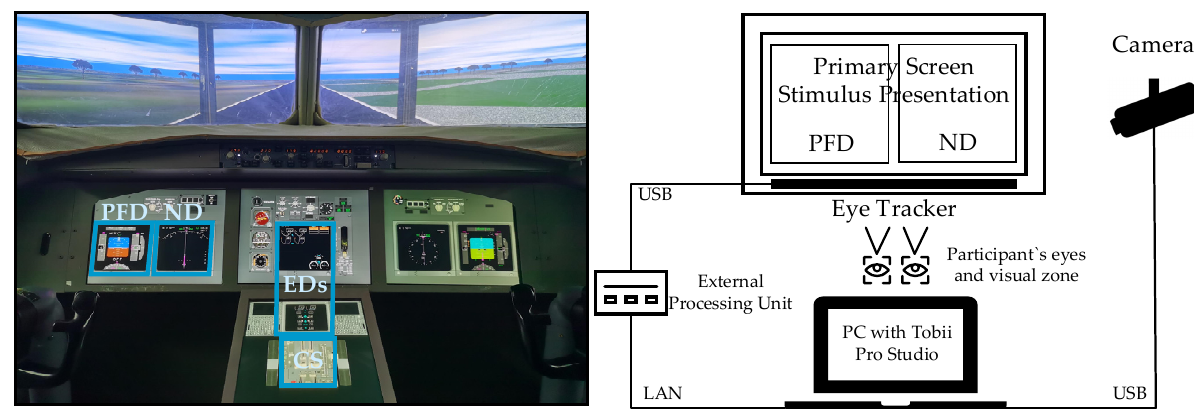
Figure 1. Simulated flight platform ( left ) and eye tracker system ( right ).